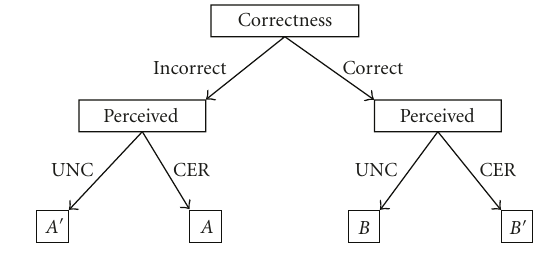
Figure 4: We divide the utterances into four subsets and train a separate classifier for each subset.